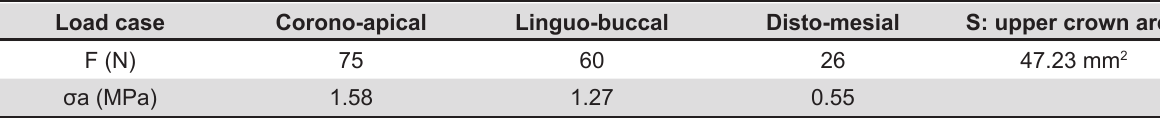
Figure 2- Boundary conditions of the mandible and loading Table 1- Applied load values in the specified directions